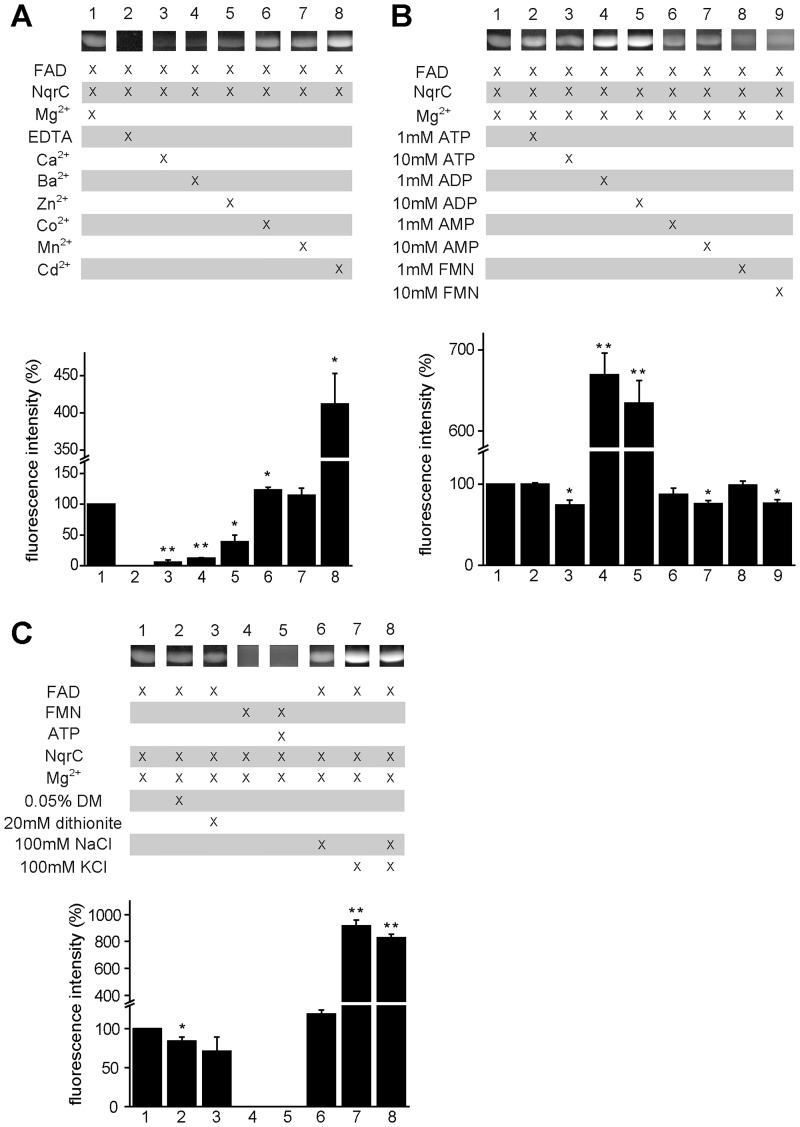
Substrate specificity of V. cholerae ApbE.Reactions were carried out as described in “MATERIALS AND METHODS” at pH 9.0. The reaction under physiologic conditions (10 μM NqrC, 1 mM FAD, 5 mM MgCl2) was used as control. Samples were collected after 10 min and mixed with 5X gel loading buffer. Samples were run in SDS-PAGE, which was later exposed to UV light. Student’s t–tests were used to determine statistical significance between control and experimental samples. *P < 0.05, **P < 0.005 (n = 3). Brightness and contrast of the images were linearly adjusted using Adobe Photoshop for better visualization. Original (unaltered) captured image files (not shown) were used for data analysis. A) ApbE activity was tested using EDTA or different cations. B) Effects of ATP, ADP, AMP and FMN on flavin transfer. C) Effects of 0.05% n-dodecyl-β-D-maltopyranoside (DM), 20 mM dithionite, FMN and monovalent cations on flavin transfer.